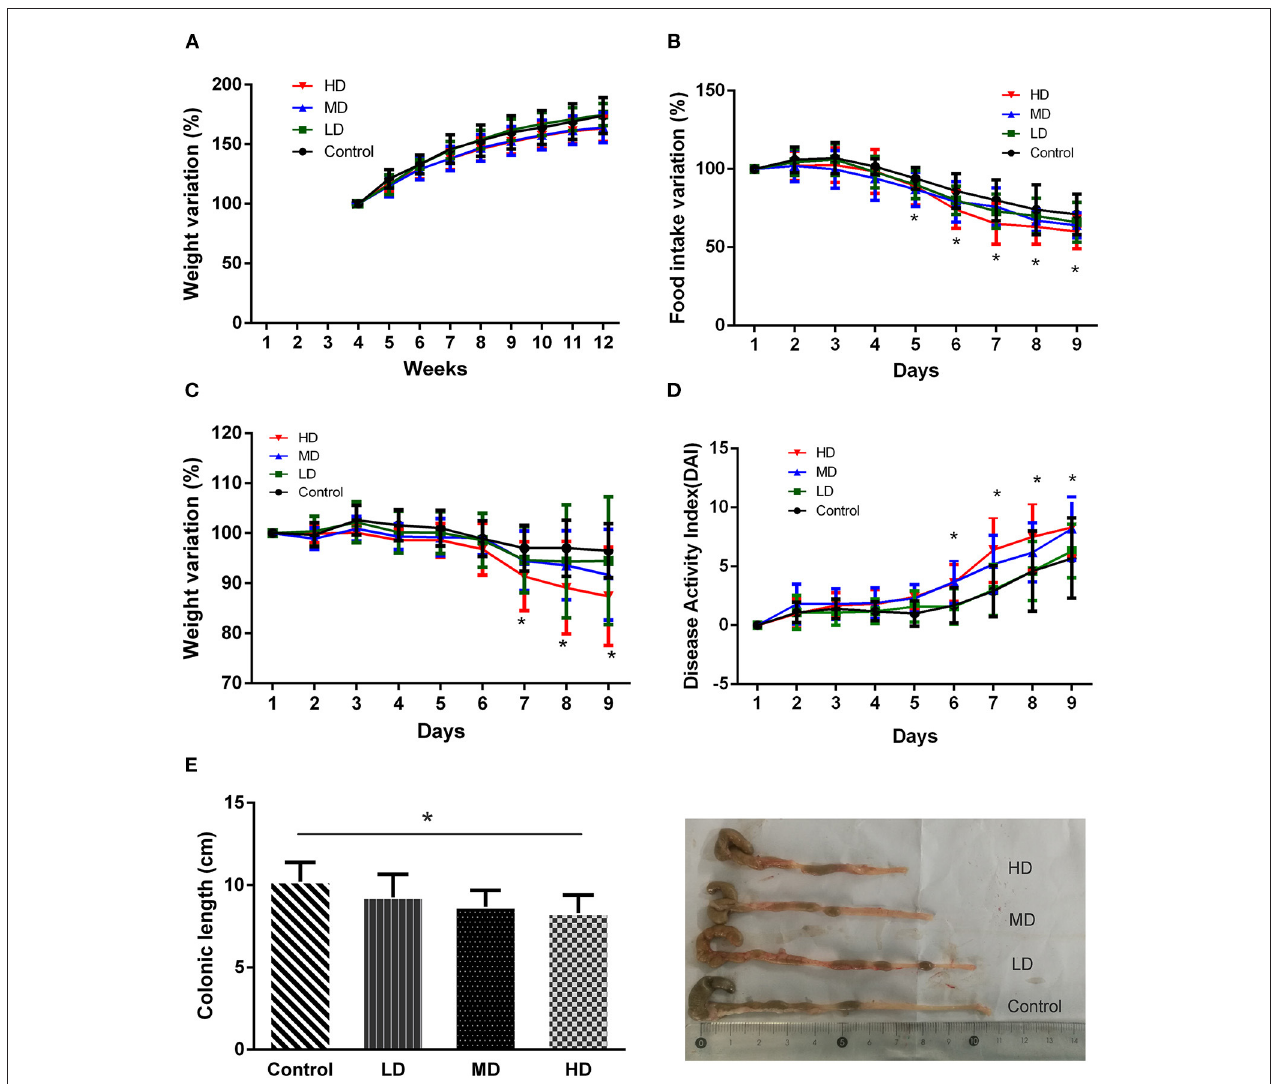
FIGURE 4 | Effects of different levels of red meat diets. (A) Body weight variation during 8 weeks of feeding with different levels of red meat diets. (B) Food intake variation of different levels of red meat diets on DSS colitis. (C) Body weight variation of different levels of red meat diets on DSS colitis. (D) Disease activity index of different levels of red meat diets on DSS colitis. (E) Comparison of different red meat diets on colonic length and representative images of DSS colitis mice. Data are presented as mean ± SD, and *indicates p <